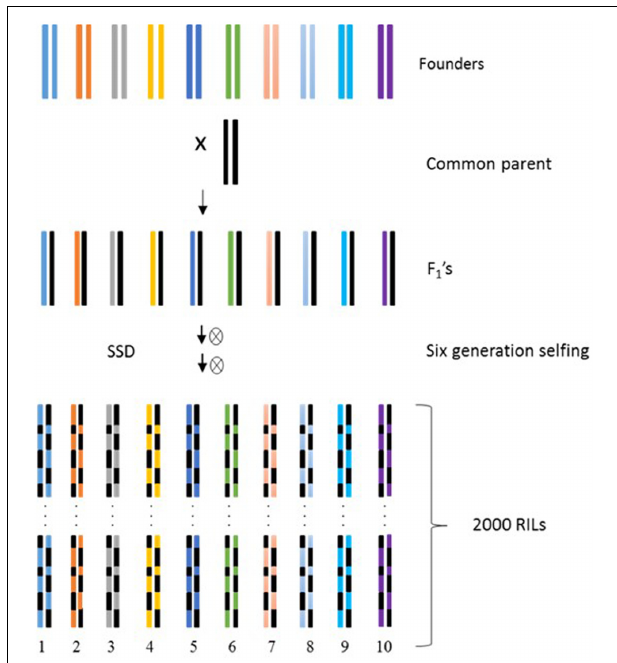
FIGURE 2 | Schematic diagram of pearl millet NAM population development. The genome of each founder is color coded to show that the genome of RIL is a mosaic of founders and common parent genome segments (adapted from Yu et al., 2008). High-density genotyping of founders permits the linkage disequilibrium information captured in these diverse founders to be exploited for high-resolution mapping (SSD, single seed